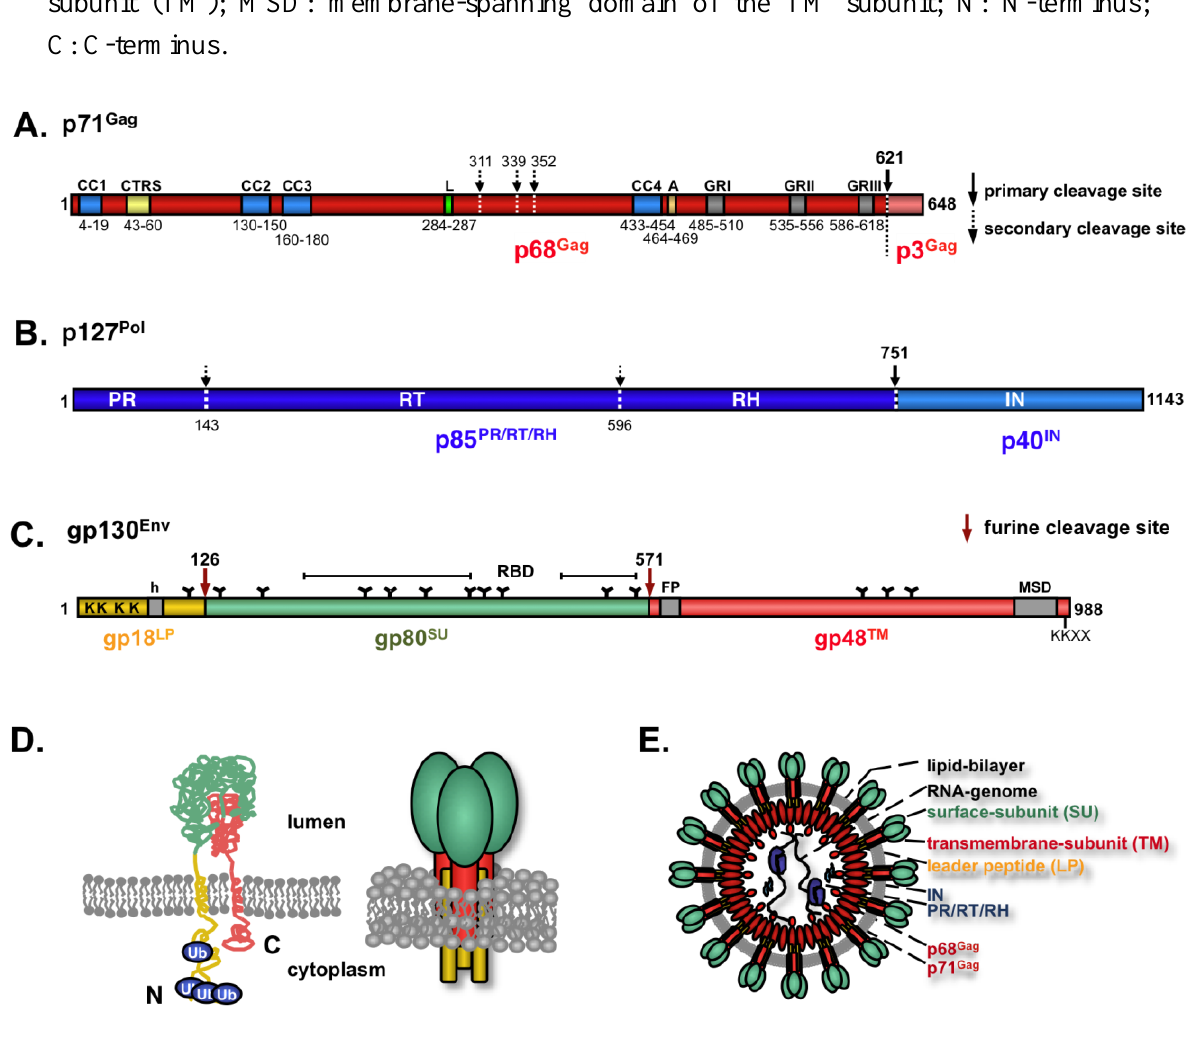
Figure 3. The spuma- or foamy viruses (FV) structural gene products. Schematic